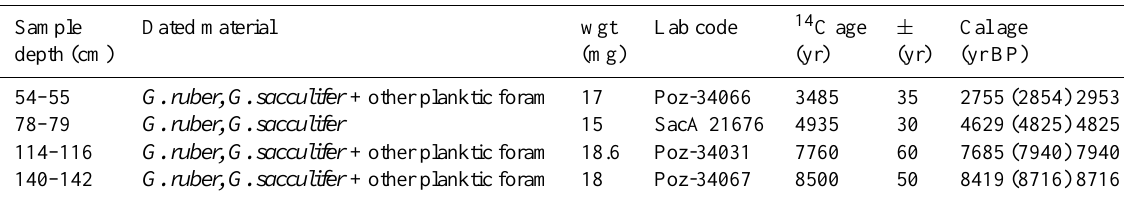
Fig. 2. Above: backscatter map of the central Algerian margin with the location of submarine cable breaks and of sediment core PSM-KS23 in the distal reaches of the Algiers turbiditic system close to one of the submarine cable breaks. Dark tones identify high backscatter areas, in particular along the thalwegs of the main canyon and turbiditic systems. In blue are the possible trajectories of turbidity flows inferred from the seafloor morphology. Below: interpretation of bathymetry and backscatter in terms of morphology and sedimentary processes in the area affected by the 2003 event. In dark orange are zones of dominant erosion within the axial areas of the main canyons; in light orange are zones of significant deposition; in yellow are the main sedimentary systems. The distal seafloor scarp S1 (black dashed lines, described in D´everch`ere et al., 2005 together with the other scarps S2 and S3) defines a structural high and limits seaward a perched basin, likely an expression of buried thrust-folds. Grey arrows represent the possible path of the 2003 turbidity currents interpreted from cable breaks, bathymetry, and backscatter. Blue arrows identify possible distal sources of submarine landslides and/or turbidites. Note the absence of cable breaks in the central part of cables COLOMBUS2 and SMW2, possibly due to deflection of turbidity currents by the scarps and confinement within a perched basin. Table 2. Radiocarbon age of four hemipelagic beds of core PSM-KS23 obtained by AMS dating performed at Poznan Radiocarbon Labo- ratory, Poland (Poz) and at Artemis facility, Saclay, France (SacA). The 14 C ages were corrected for a reservoir effect of 400 yr, calibrated with Calib 6.0 (Stuiver et al., 2010) and reported as 2 sigma